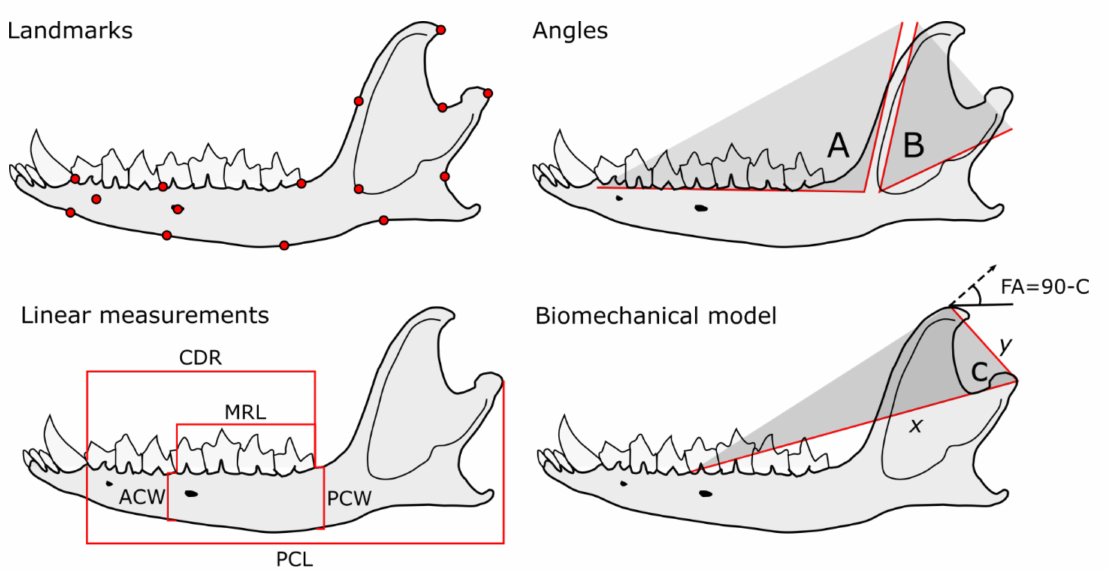
Figure 2. Summary of landmarks, angles and measures of Thylamys elegans , the descriptions of angles A and B are defined in the Section 2.2 and the angle C in Section